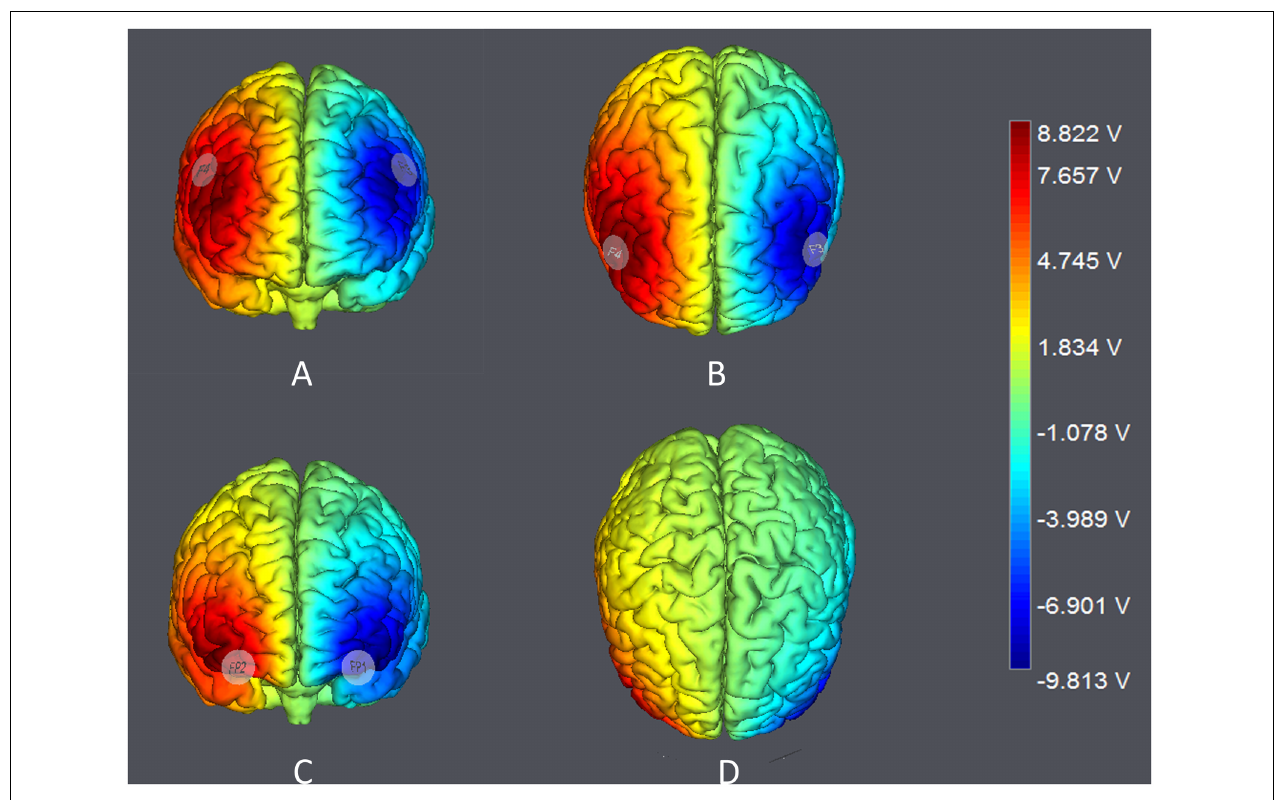
FIGURE 2 | Electric simulations performed with the tDCS neurostimulator software. (A,B) simulations of right anodal/left cathodal DLPFC stimulation; (C,D) simulations of right anodal/left cathodal OFC